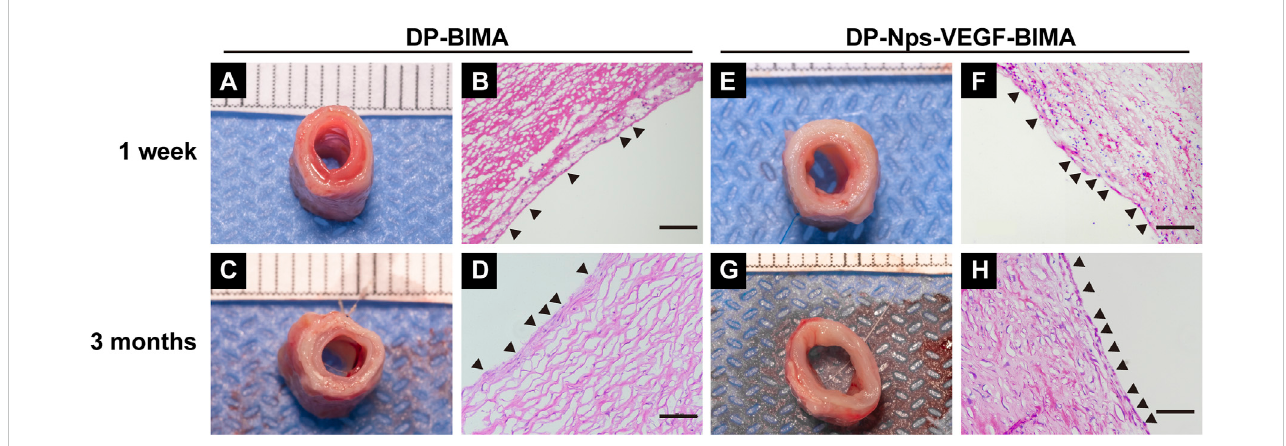
FIGURE 9 The photos and H&E images of the middle segments of the implanted DP-BIMA (A – D) and DP-Nps-VEGF-BIMA (E – H) . The black triangles indicates the ECs-like cells.